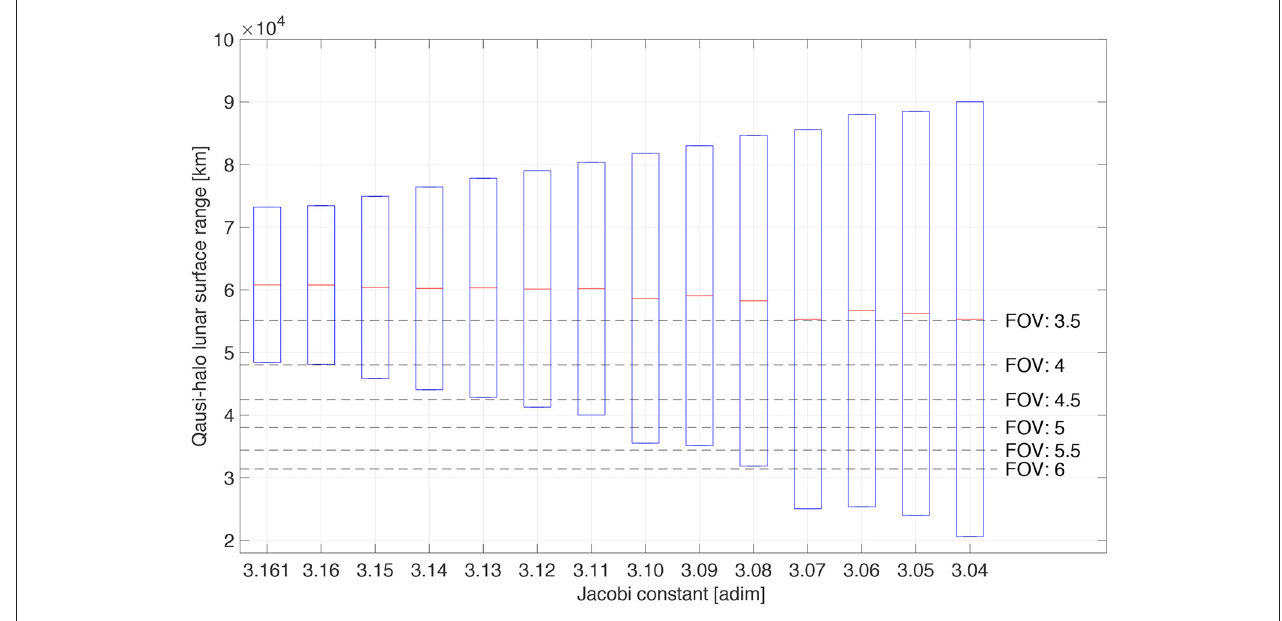
FIGURE 7 | Bars for quasi-halos ranges from lunar